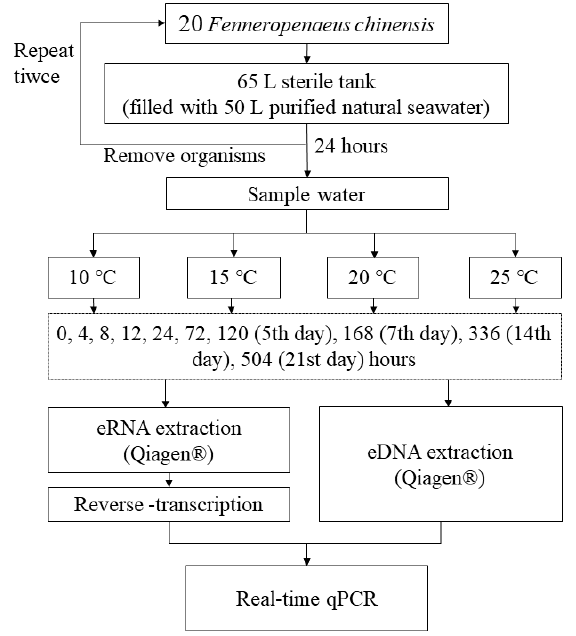
Figure 1. Flow chart describing the four different treatment protocols applied to Fenneropenaeus chinensis -associated eRNA and eDNA purification and detection. After the F. chinensis were removed, the water samples were treated at different temperatures (10, 15, 20 and 25 °C) and sampled at 0, 4, 8, 12, 24, 72, 120, 168, 336 and 504 h for filtration and subsequent operations.